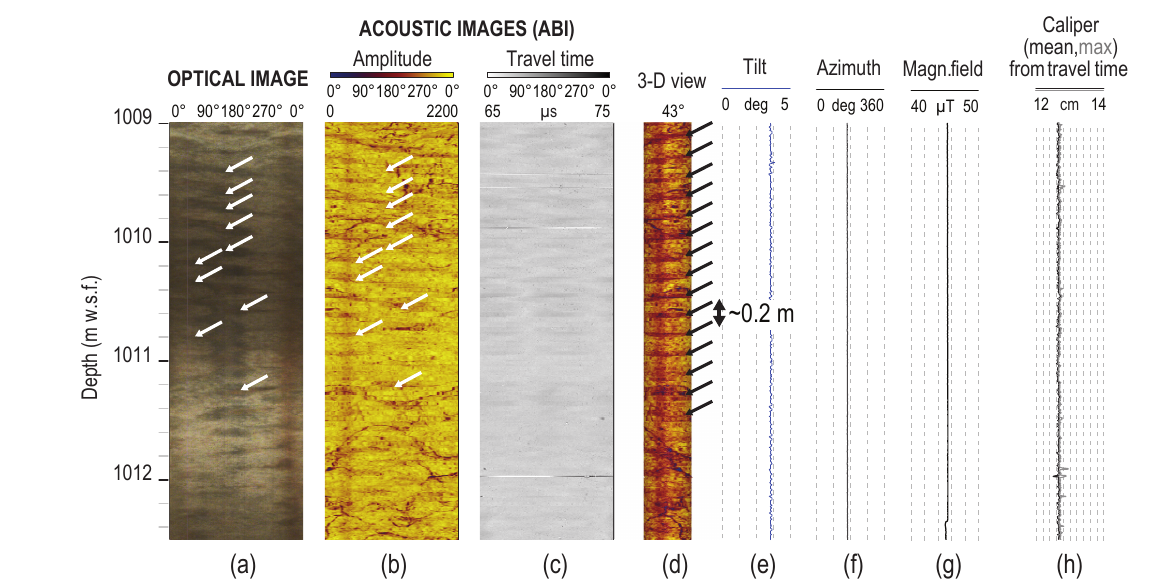
Figure 7. Drilling-induced helical marking on the borehole wall, evidenced by helical stripes (arrows) on both the optical and acoustic borehole images. mw.s.f. is meter wireline depth below seafloor.